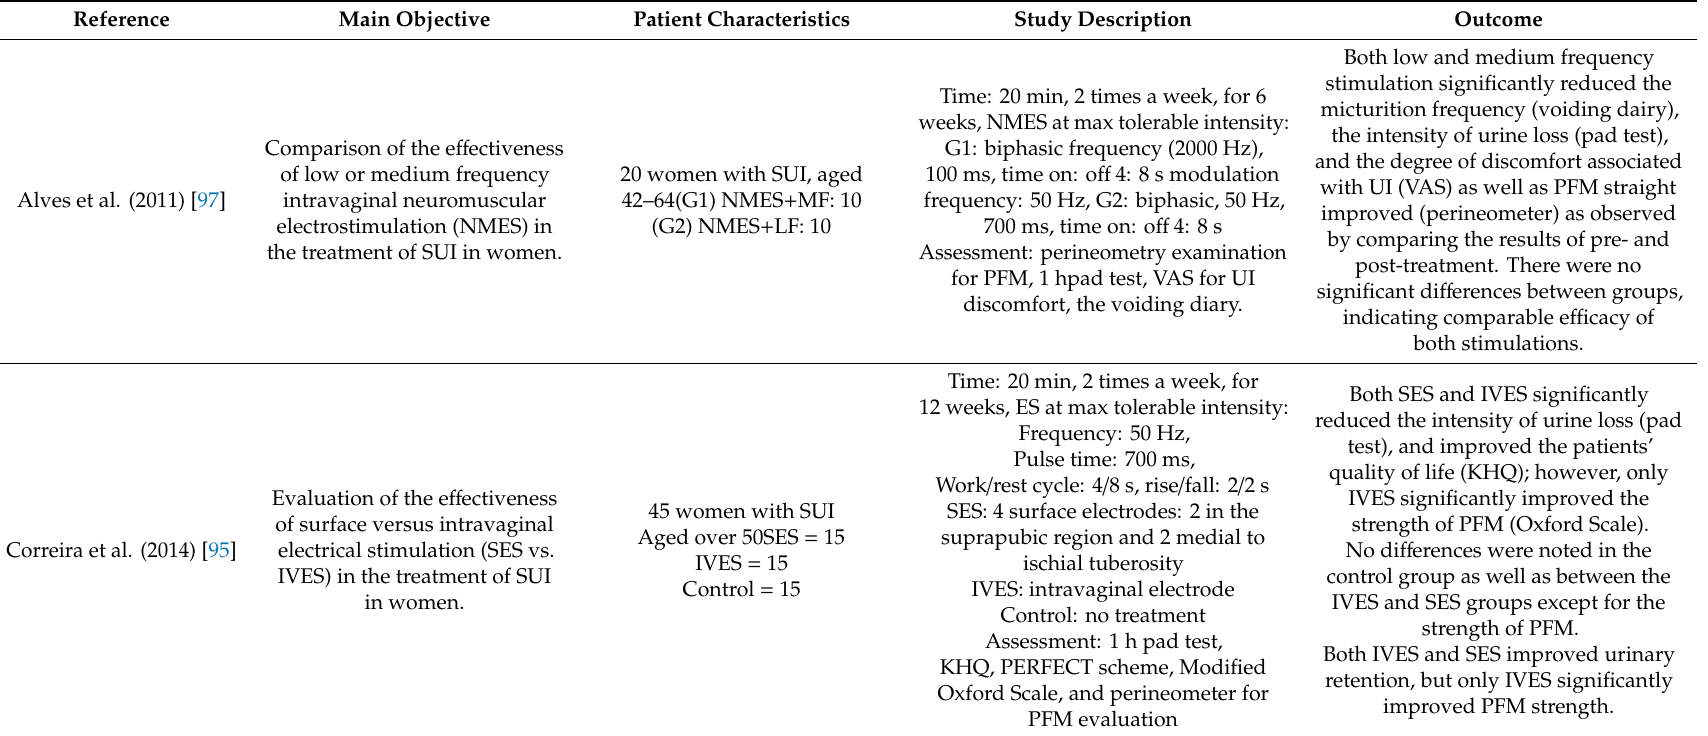
Table 3. Characteristic of selected studies on the e ff ects of electrical stimulation on the pelvic floor muscles (PFMs) activity and / or severity of urinary incontinence (UI)